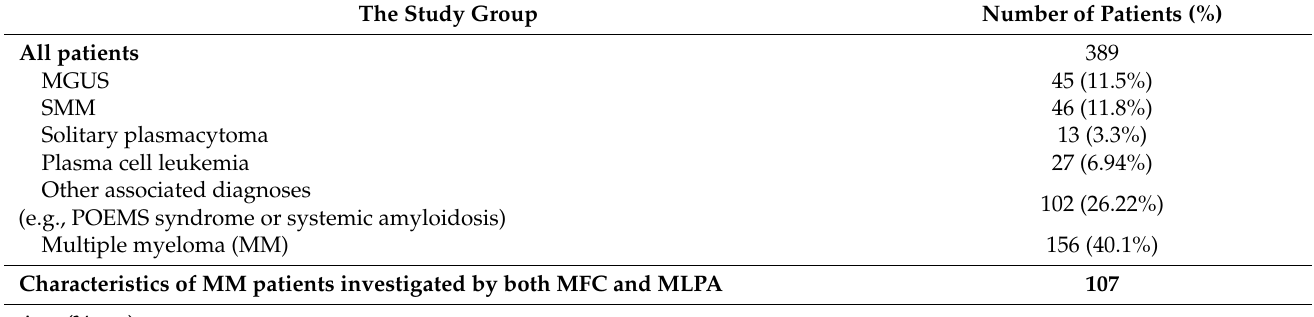
Table 1. The characteristics of the study group.